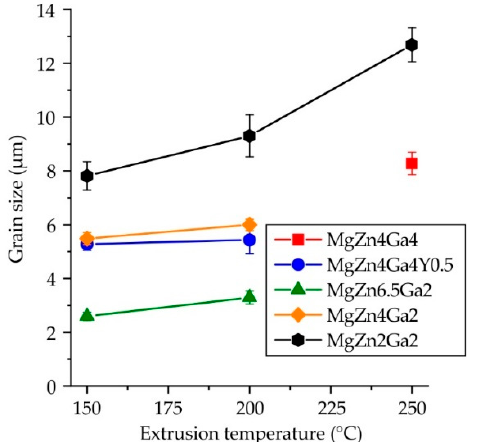
Figure 8. Average grain size vs. extrusion temperature of the Mg–Zn–Ga–(Y) alloys. Increasing the Zn content from 2 to 6.5 wt.% resulted in a three-fold decrease in the grain size. In contrast, Ga had little effect on the grain size of the hot-extruded alloys. The Mg 5 Ga 2 and Mg 12 Zn 13 phases were dynamically precipitated during extrusion and can act as pinning obstacles in the growth of DRX grains via the Zener drag effect [44,45]. However, Mg 12 Zn 13 precipitates are more effective for forming a fine grain structure. Previously, it was shown that MgZn4Ga4 after ECAP at 310 °C has a bimodal structure that comprises large grains surrounded by small grains [33]. In contrast with ECAP, extrusion of the alloy promoted unimodal microstructure formation. Figure 9 shows the XRD spectra of the Mg–Zn–Ga–(Y) alloys after extrusion at 150 °C. The extrusion temperature had little influence on the phase composition of the investigated alloys, and the XRD spectra of the alloys after hot extrusion at 200 or 250 °C, were the same as those at 150 °C and are not shown. In all alloys, the α -Mg, Mg 5 Ga 2 , and Mg 12 Zn 13 phases were observed, as confirmed by the TEM EDS results of the extruded alloys (Figure 7). Further, the XRD peaks of the Mg 2 Ga 5 and MgGa phase were not observed for the extruded alloys because of their low fraction compared to the Mg 5 Ga 2 phase. The alloy with added Y in extruded state contained a Ga–Y phase (the peaks corresponds to both Ga 6 Y and Ga 3 Y 5 ) that confirmed the EDS results of as-cast alloy and opposite to CALPHAD calculation results via FactSage. This can be connected with FTlite thermodynamic database limits. Figure 9. XRD patterns of ( a ) MgZn4Ga4, ( b ) MgZn4Ga4Y0.5, ( c ) MgZn6.5Ga2, ( d ) MgZn4Ga2, ( e ) MgZn2Ga2 after hot extrusion at 150 °C.